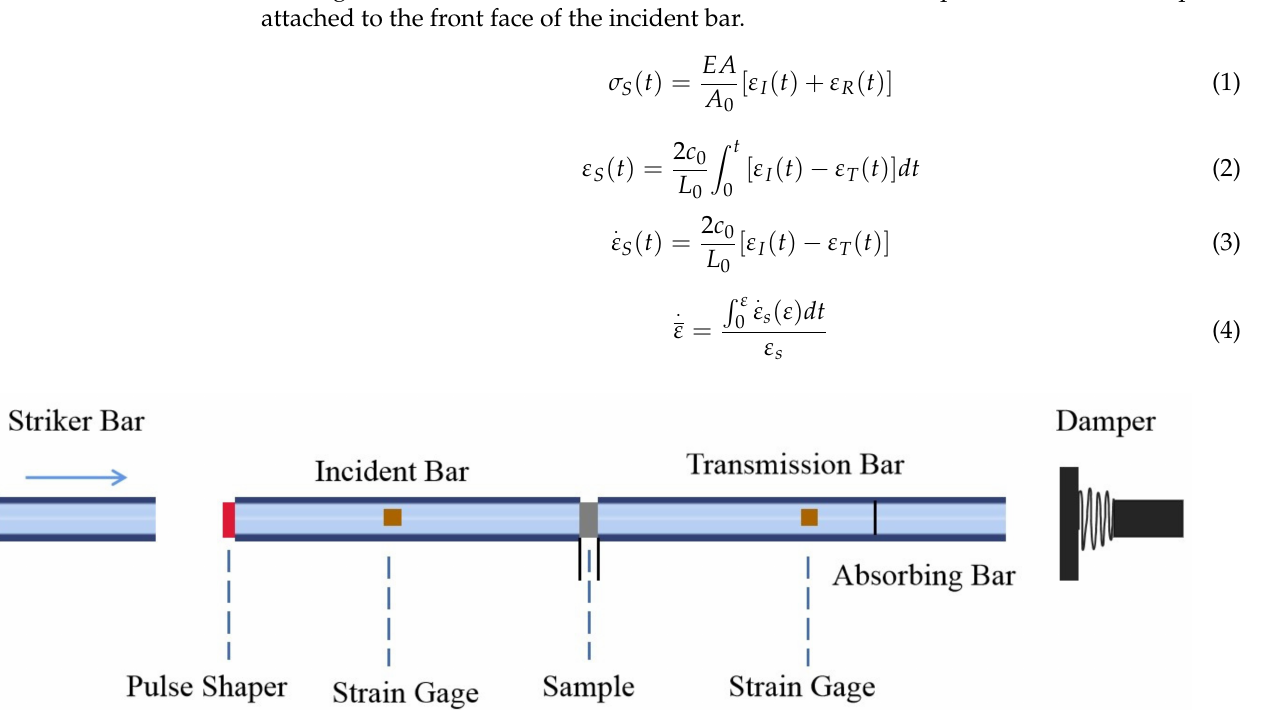
Figure 3. Schematic diagram of the SHPB